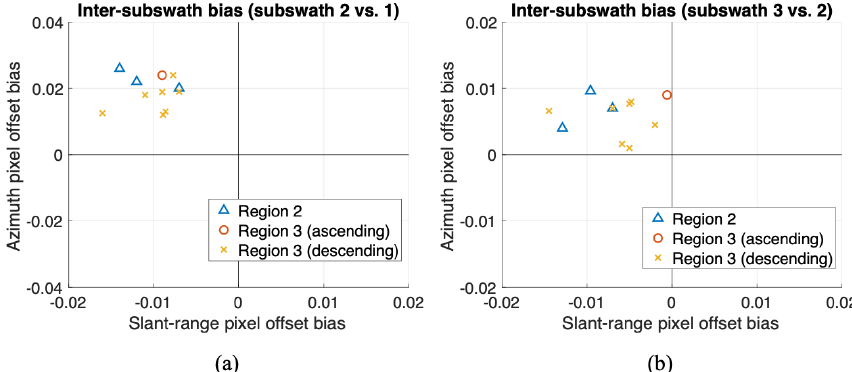
Figure 8. Inter-subswath bias of slant range and azimuth offsets: (a) subswath 2 versus 1, (b) subswath 3 versus 2. The 11 Sentinel-1A/B image pairs in Region 2 and Region 3 are shown